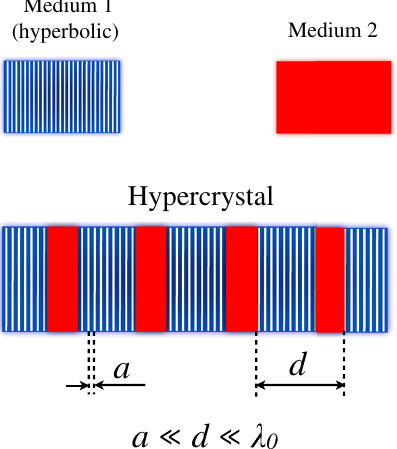
FIG. 1. A hypercrystal is formed by introducing a periodic variation in a hyperbolic medium, with the period smaller than the free-space wavelength d ≪ λ 0 but well above the unit cell size of the hyperbolic (meta)material: d ≫ a . The desired periodic variation can be achieved by introducing a second medium (which could be either a metal, or a dielectric, or another hyperbolic medium with a different dielectric permittivity tensor) in the design of the